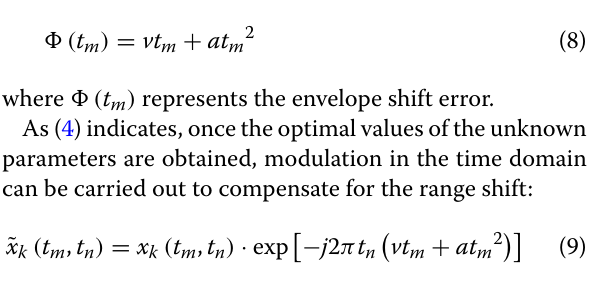
parameters, i.e., acceleration a and velocity v :